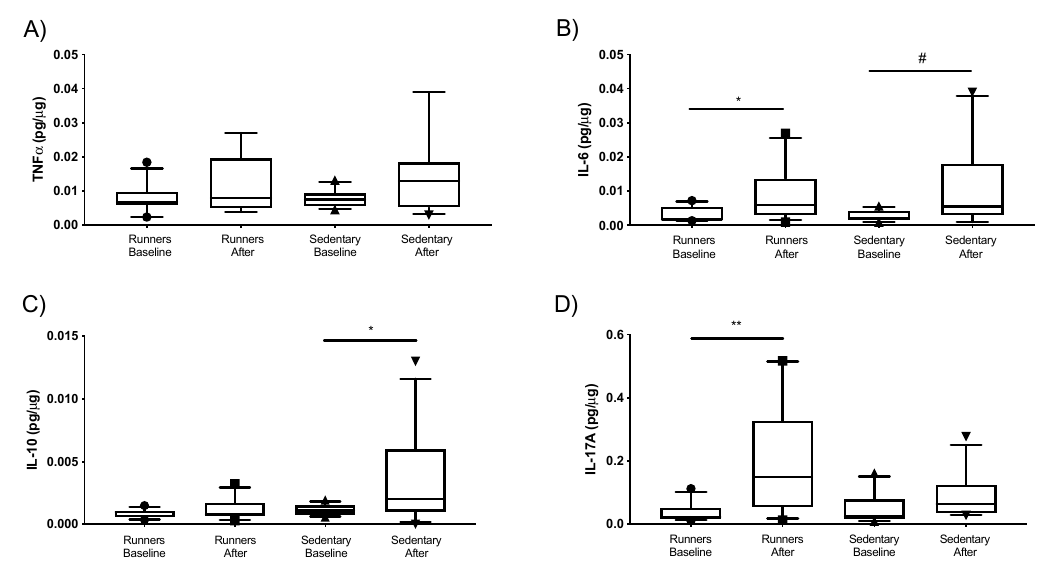
Figure 3. Cytokine concentrations: ( A ) TNF- α , ( B ) IL-6, ( C ) IL-10, and ( D ) IL-17A of nasal lavage fluid were characterized by a median with an interquartile range and compared between groups and sampling moments. The Wilcoxon test was used. * p = 0.037, # p = 0.027, ** p = 0.001. Significance p < 0.05.